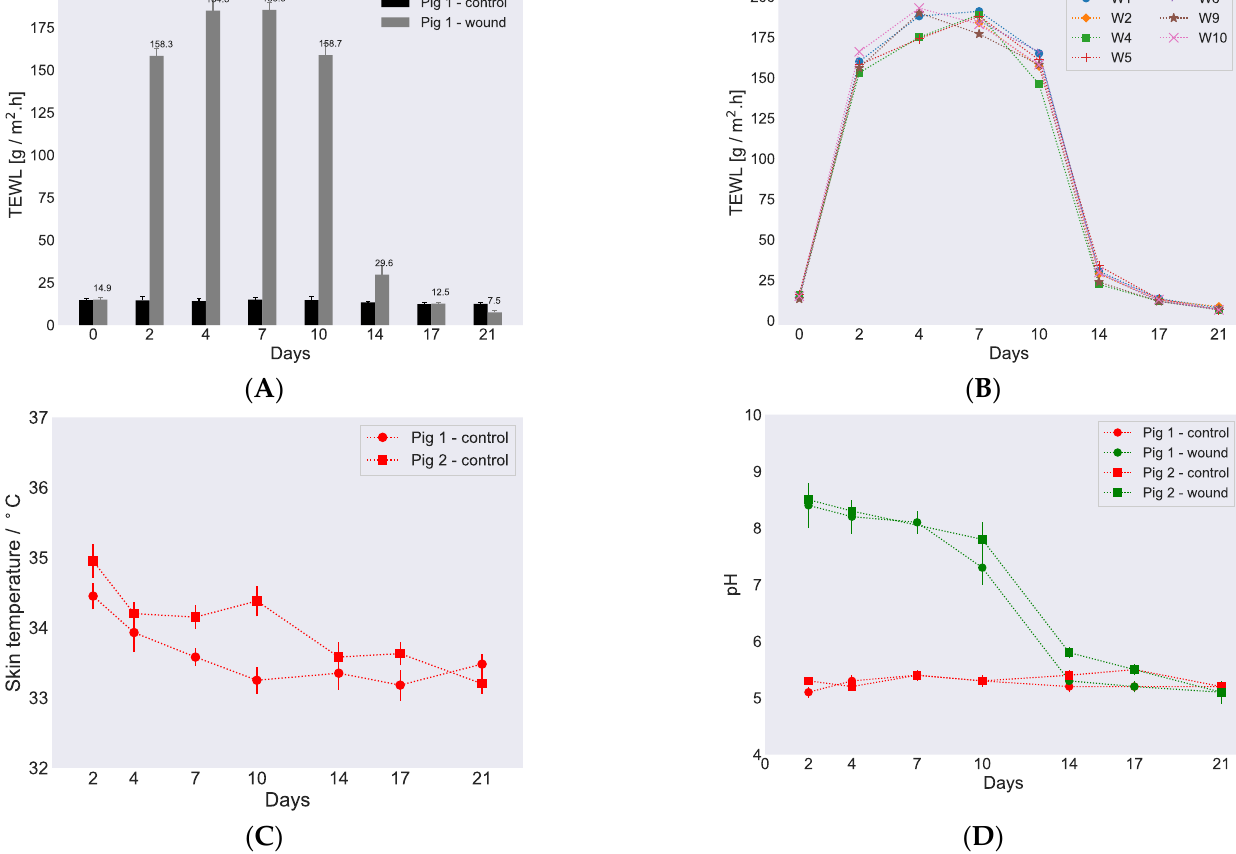
Figure 3. Variations in TEWL, skin temperature, and pH during healing. ( A ) Measured TEWL vs. time for control skin and healing skin for pig 1, position 1. On day 0, the readings were recorded before the wound incision. ( B ) TEWL values vs. time for individual wounds obtained from pig 1 when the wound dressings were changed. ( C ) Skin surface temperature vs. time measured on both pigs. ( D ) pH measurements on the wounds (position 1, pig 1, and position 5, pig 2) and corresponding control sites were plotted vs. time for both pigs. All the TEWL and pH values were recorded at ambient controlled conditions, i.e., approximately 50% relative humidity (RH) and 23 °C. Error bars depict standard deviation.